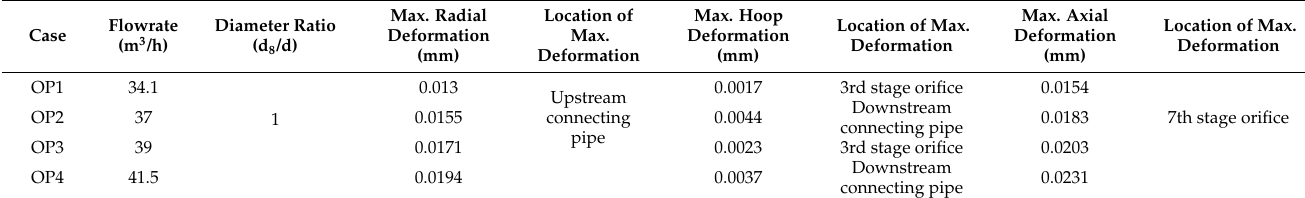
Table 7. The predicted results of deformation components depending on the operating flow